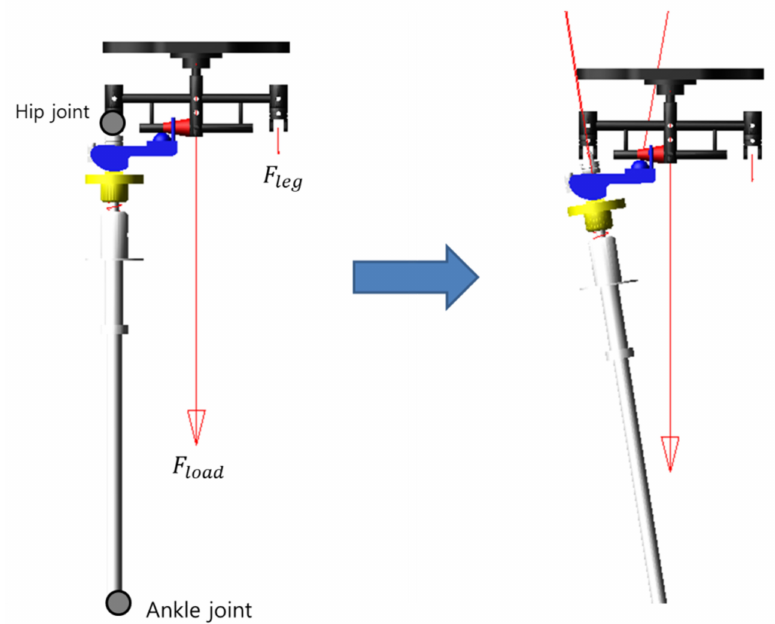
Figure 5. Adams simulation environment.